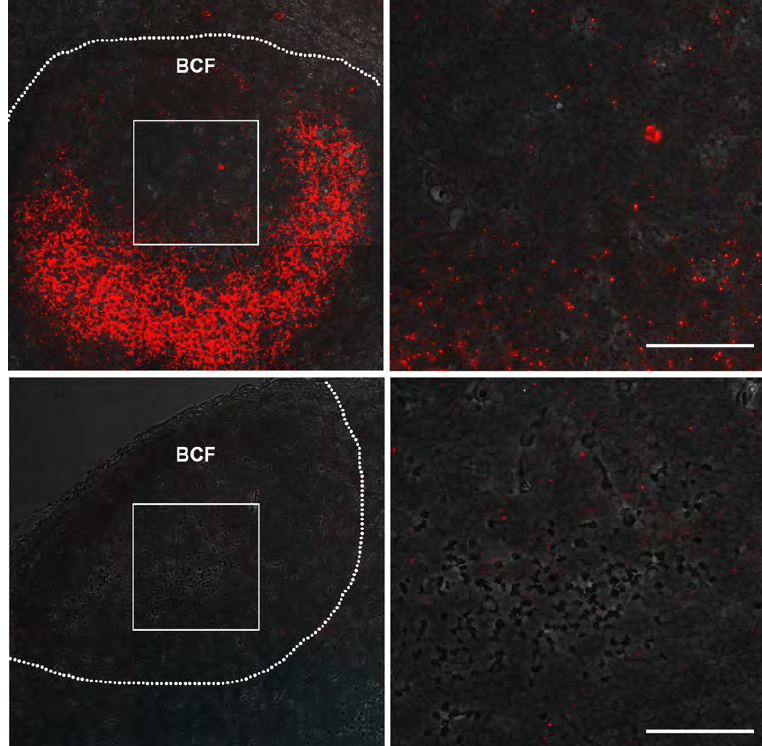
Figure 3. Utility of RNAscope for the detection and quantification of vRNA+ cells in a combination antiretroviral therapy (cART) SIV NHP model with strong correlation to qRT-PCR. (A) The number of vRNA+ cells quantified by RNAscope and (B) the number of vRNA copies quantified by qRT-PCR are (C) strongly correlated before and during cART. Data were log10 transformed and P values were based on associations between paired comparisons using the Pearson’s Correlation test. (D) The proportions of vRNA+ cells within distinct secondary lymphoid tissue anatomical sites (i.e., B cell follicles (BCF), T cell zone, and medullary cords) before and (E) during cART. P values were based on the Mann-Whitney test. (F) The frequency of vRNA+ cells in BCF increased, while that of vRNA+ cells in T cell zone decreased. The proportion of vRNA+ cells within the MC is unchanged, suggesting a steady rate of cell trafficking. P values were based on the Wilcoxon matched-pairs signed rank test. (G) RNAscope in situ hybridization (ISH) has the ability to detect low-level vRNA+ cells (not shown) and FDC-bound viral particles in chron- ically SIV+ RMs before (top panel) and after 26 weeks of cART (bottom panel). Scale bars = 50